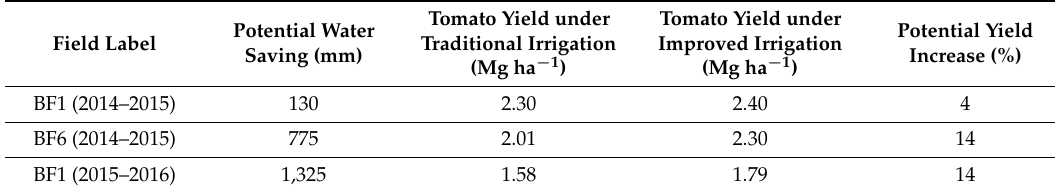
Table 5. Potential water saving and yield increase under the improved irrigation schedule as simulated in AquaCrop.